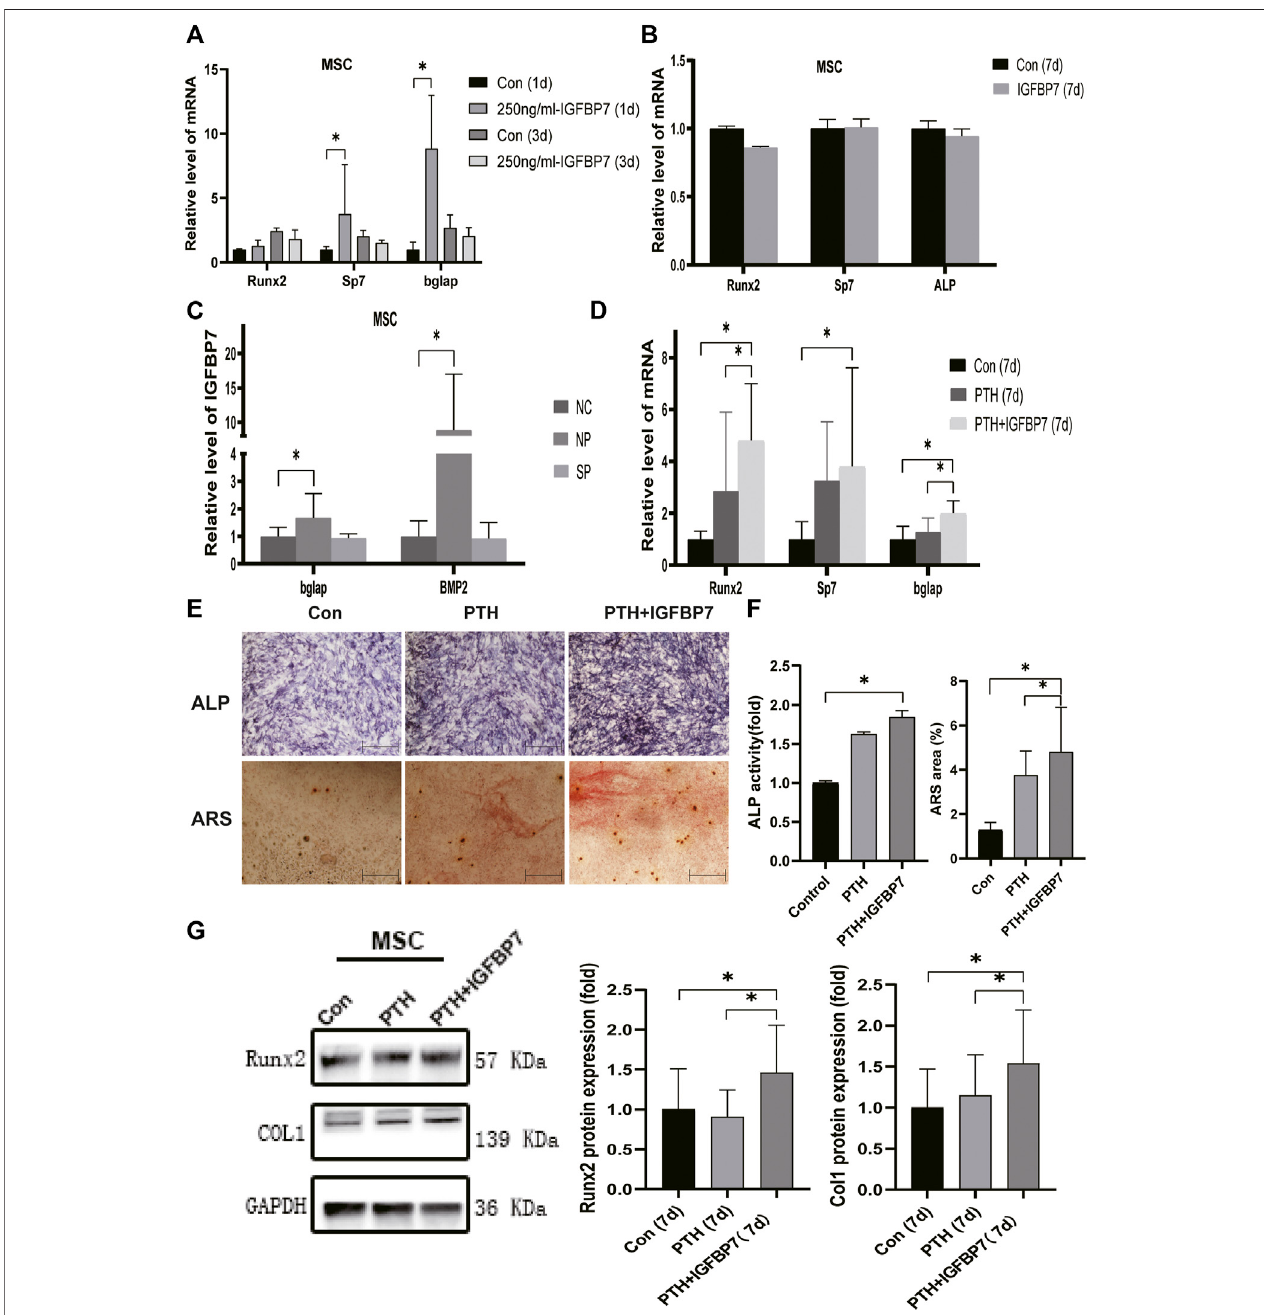
FIGURE3| ImpactsofIGFBP7onosteogenicdifferentiationofMSCsinducedbyiPTH. (A) ThemRNAexpressionofosteogenicmarkergenesinducedby250 mg/ mlIGFBP7fordoneandd3. (B) RelativemRNAexpressions ofosteogenicmarkergenesinIGFBP7groupond7. (C) RelativemRNAexpressionsofosteogenicmarker genesinducedbyiPTHfor4/24 hond1aftertransfectioninBMSCsinthenegativecontrolgroup(NP)andIGFBP7silencedgroup(SP). (D) RelativemRNAexpressions of osteogenic marker genes induced by iPTH alone (PTH group) and IGFBP7 combined with PTH (PTH + IGFBP7 group) for 7 days. (E) ALP staining on day 7; Scalebars,400 μ m.Alizarinredstainingonday14;Scalebars,400 μ m. (F) quanti fi cationofALPactivityandcalciumdepositioninducedbyiPTHalone(PTHgroup)and IGFBP7 combined with PTH (PTH + IGFBP7 group). (G) Relative protein expressions of Runx2 and COL1 in MSCs induced by iPTH alone (PTH group) and IGFBP7 combined with PTH (PTH + IGFBP7 group) for 7 days * p < 0.05.